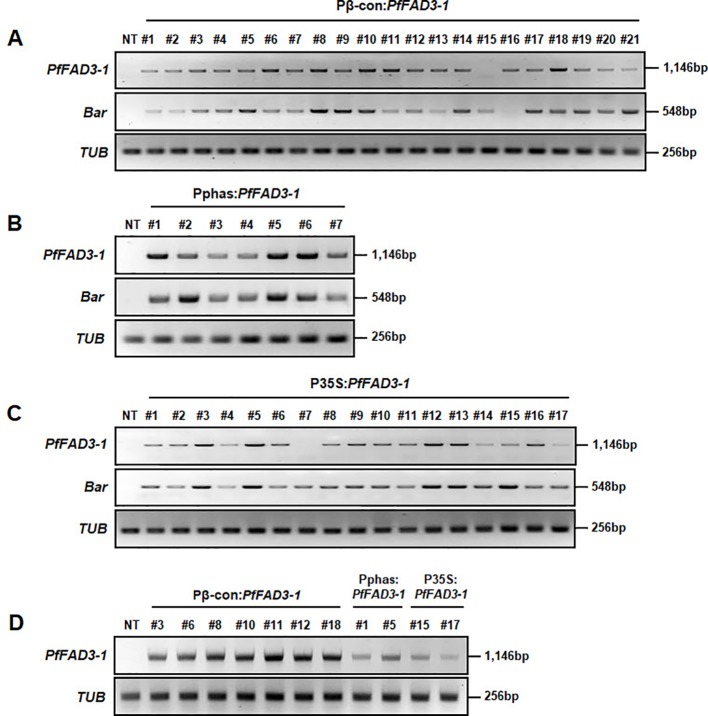
Transcript levels of PfFAD3-1 and Bar genes in transgenic plants (T0) and seeds (T2) using reverse transcriptase PCR (RT-PCR). Total RNA was extracted from Pβ-con:PfFAD3-1
(A), Pphas : PfFAD3-1
(B), and P35S:PfFAD3-1
(C) T0 transgenic leaf tissues and from T2 seeds (D). The TUB gene was used as a quantitative control. NT, non-transgenic plant; #1–#21 (part A), Pβ-con:PfFAD3-1 transgenic lines (T0); #1–#7 (part B), Pphas : PfFAD3-1 transgenic lines (T0); #1–#17 (part C), P35S:PfFAD3-1 transgenic lines (T0); #3, #6, #8, #11, #12, and #18, T2 seeds of Pβ-con:PfFAD3-1 transgenic lines; #1 and #5, T2 seeds of Pphas : PfFAD3-1 transgenic lines; #15 and #17, T2 seeds of P35S:PfFAD3-1 transgenic lines (part D).